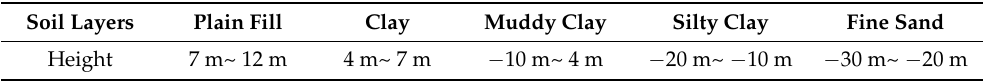
Table 4. The height of soil layers in the